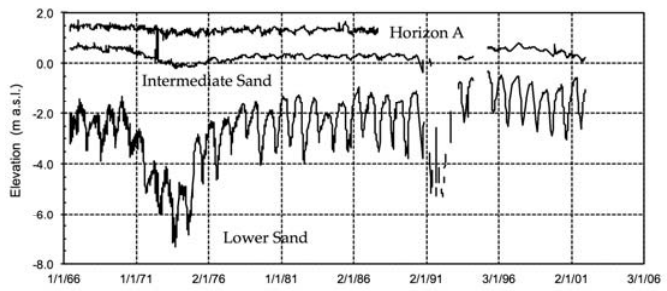
Figure 4. Water head in Horizon A (3), intermediate sand (2) and lower sand (1). (After Viggiani and Pepe, 2005 [11]).